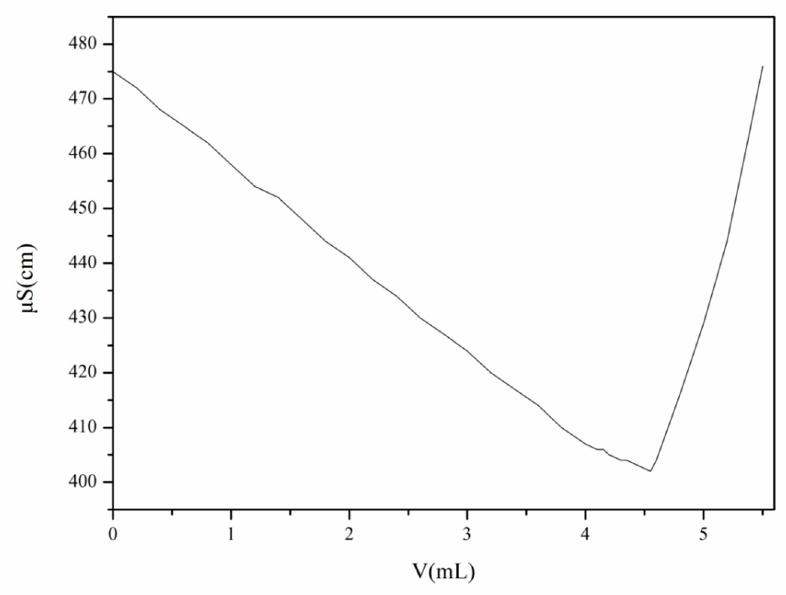
Figure 8. The curve of conductivity of solution with volume of AgNO 3 .